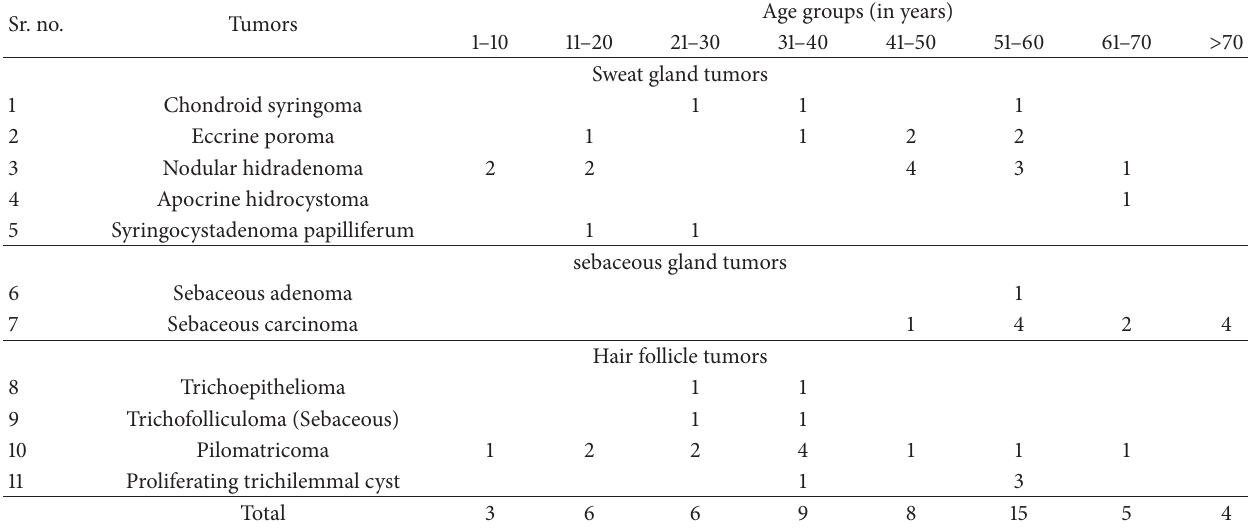
Table 3: Age incidence of individual adnexal tumors observed in the present study. Sr.